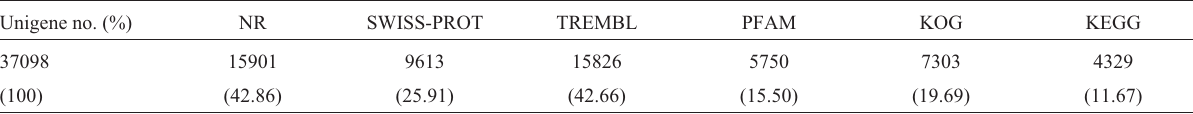
Table 3 - Functional annotation of the L. dispar transcriptome. Unigene no. (%)